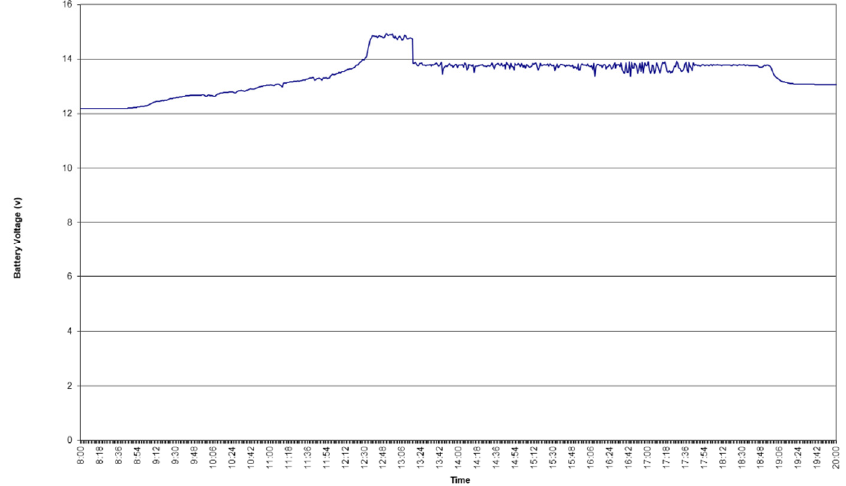
Figure 3. Evolution of the battery voltage in a three-stage charging process.